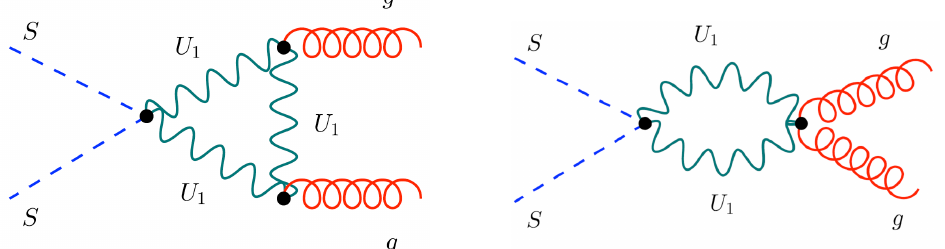
Figure 1 . Diagrams generating the SSgg